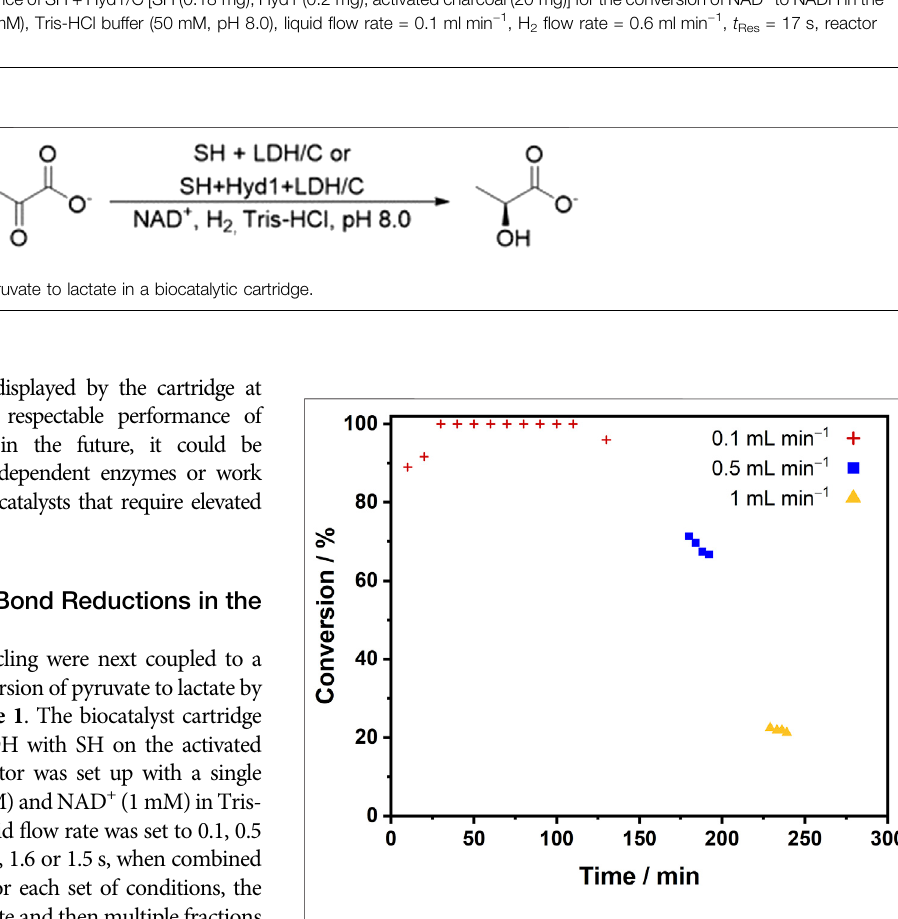
FIGURE 7 | Conversion of pyruvate to lactate using SH + LDH/C [SH (1.6 mg), LDH (3 mg), activated charcoal (43 mg)] under liquid fl ow rates of 0.1 ml min − 1 , 0.5 ml min − 1 and 1 ml min − 1 in the hydrogenation fl ow reactor. Reaction conditions: pyruvate (10 mM), NAD + (1 mM), Tris-HCl buffer (50 mM, pH 8.0), 25 ° C, liquid fl ow rate (cid:1) 0.1, 0.5 or 1 ml min − 1 , gas fl ow rate ≈ 7 ml min − 1 , reactor volume (cid:1) 0.2